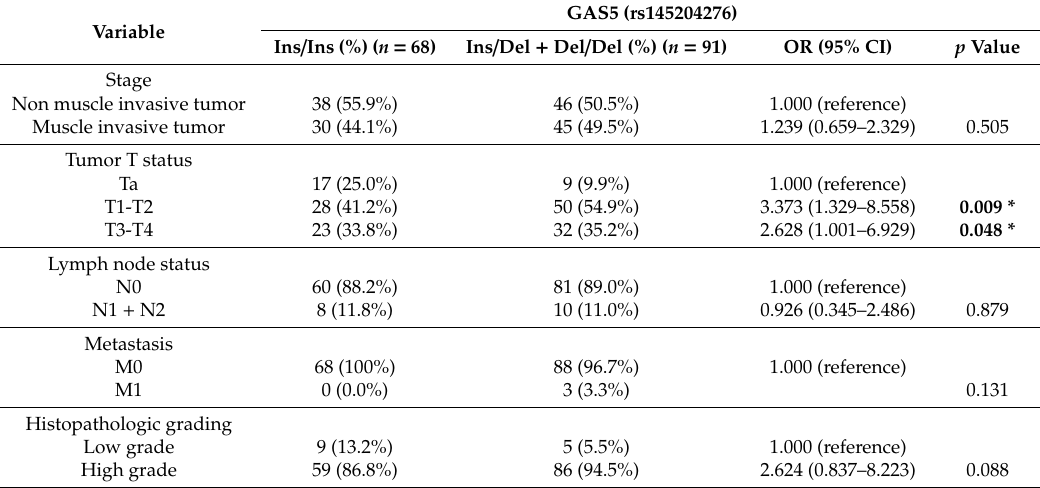
Table 4. Distribution frequency of the clinical status and GAS5 rs145204276 genotype frequencies in 159 female UCC